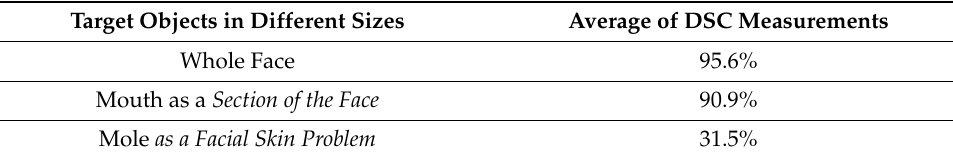
Table 3. Performance measurements of detecting objects in different